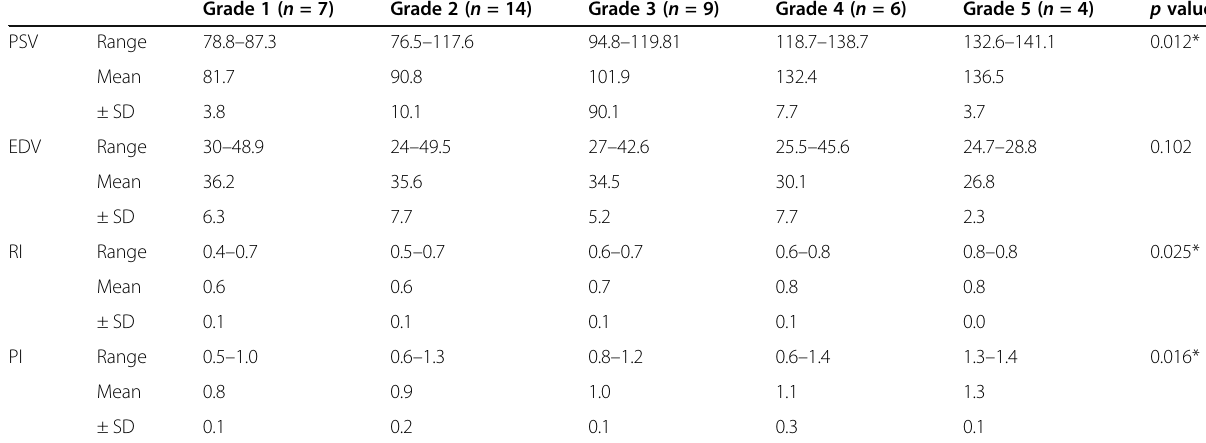
Table 2 Comparison between grades of papilledema as regards TCD parameters Grade 1 ( n = 7)